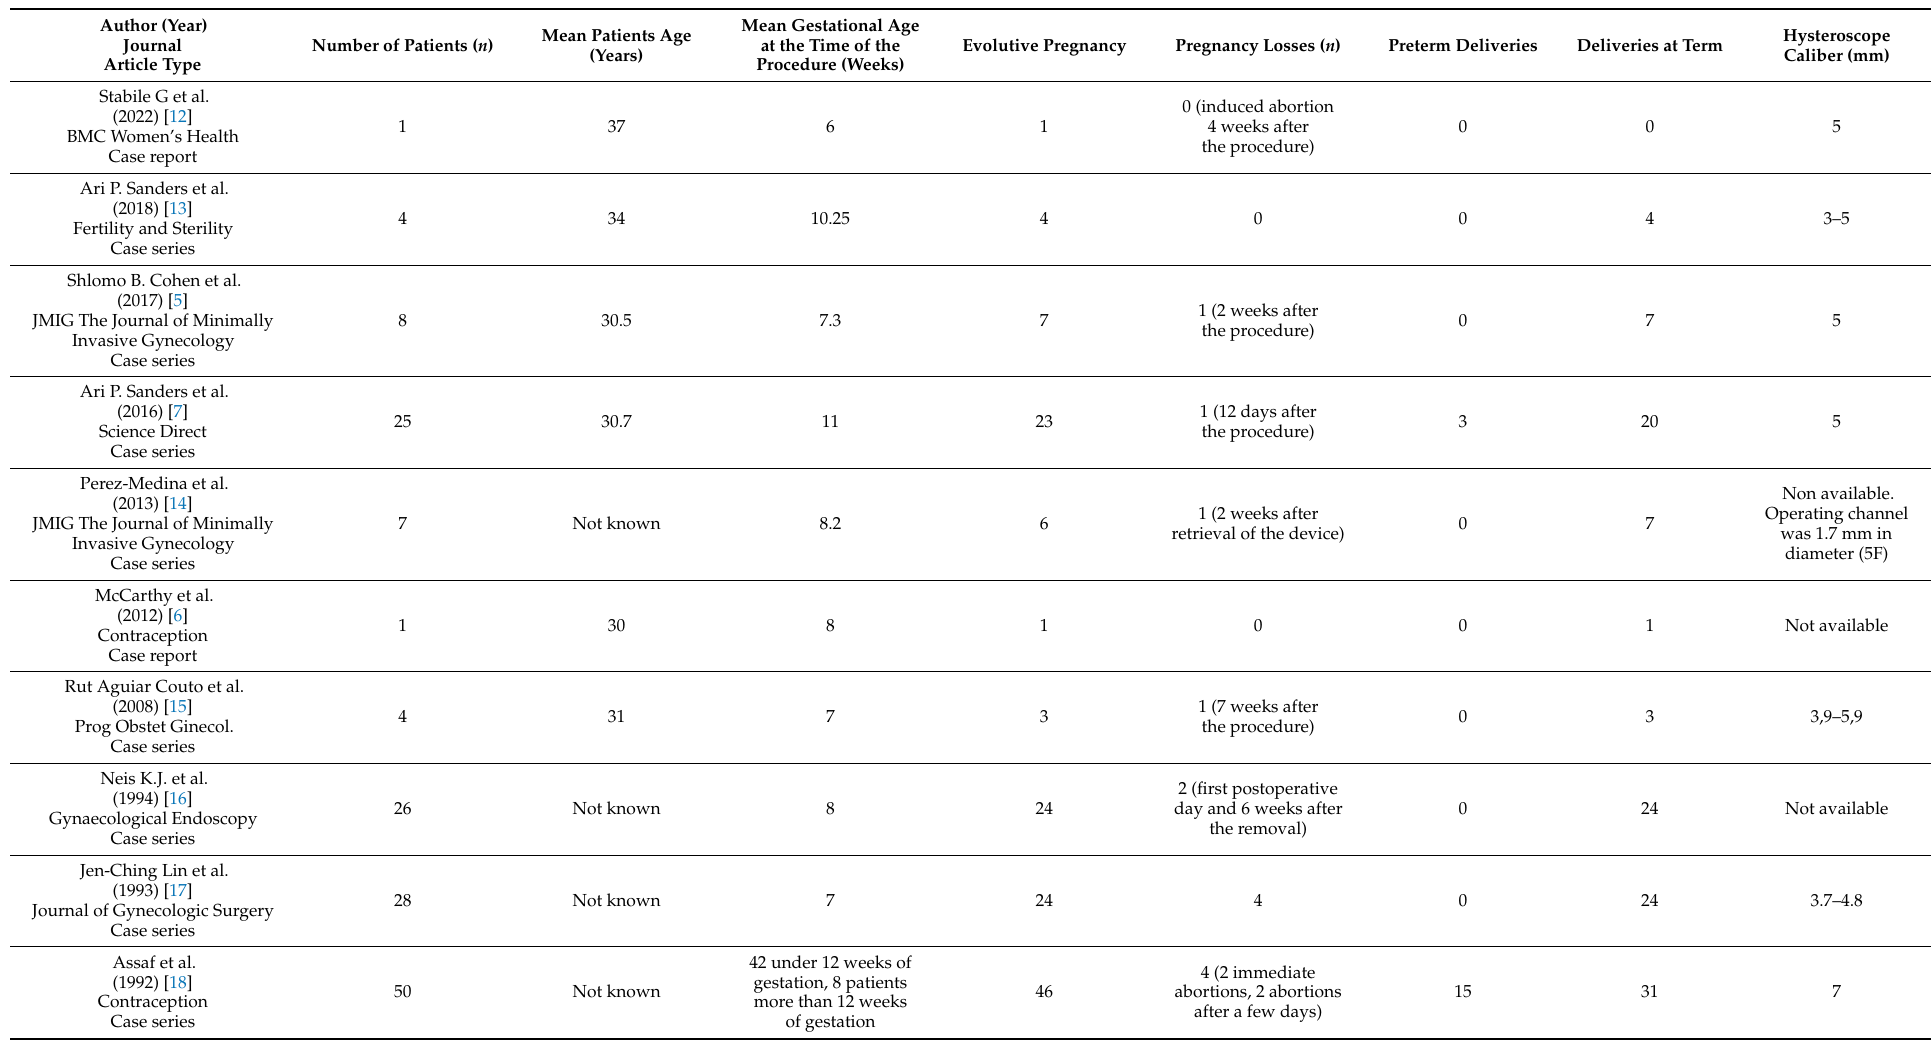
Table 1. Cases in the